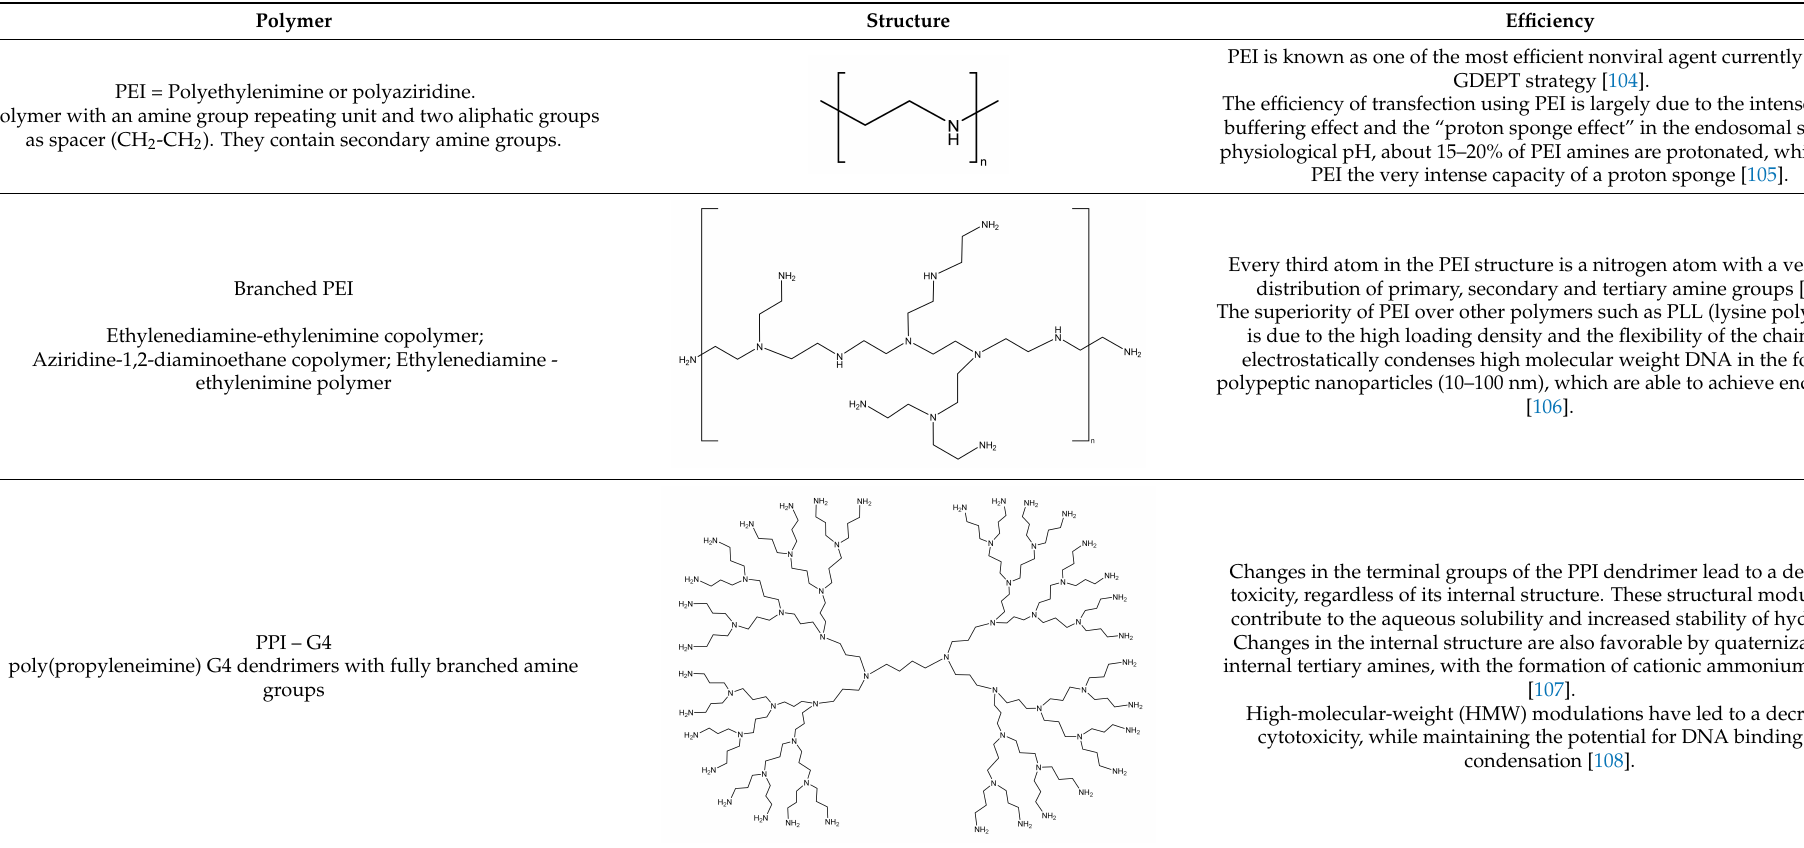
Table 1. Examples of polymers used in